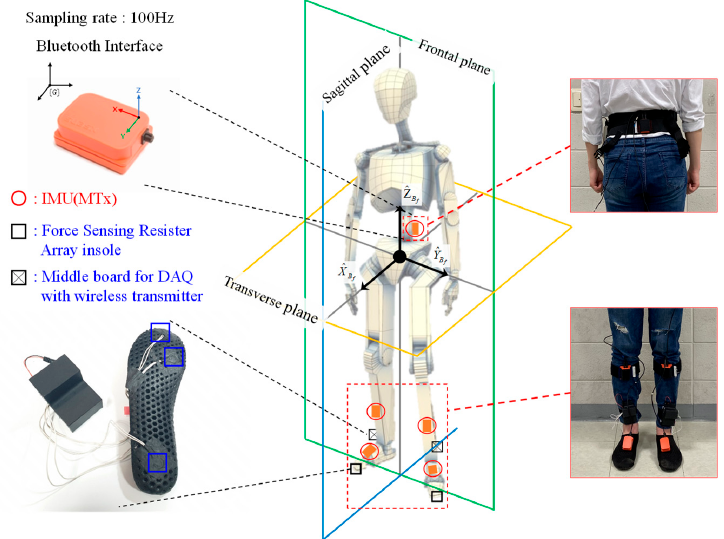
Figure 7. Configuration of the designed wearable experimental equipment for labeled lower-limb walking motion dataset acquisition.